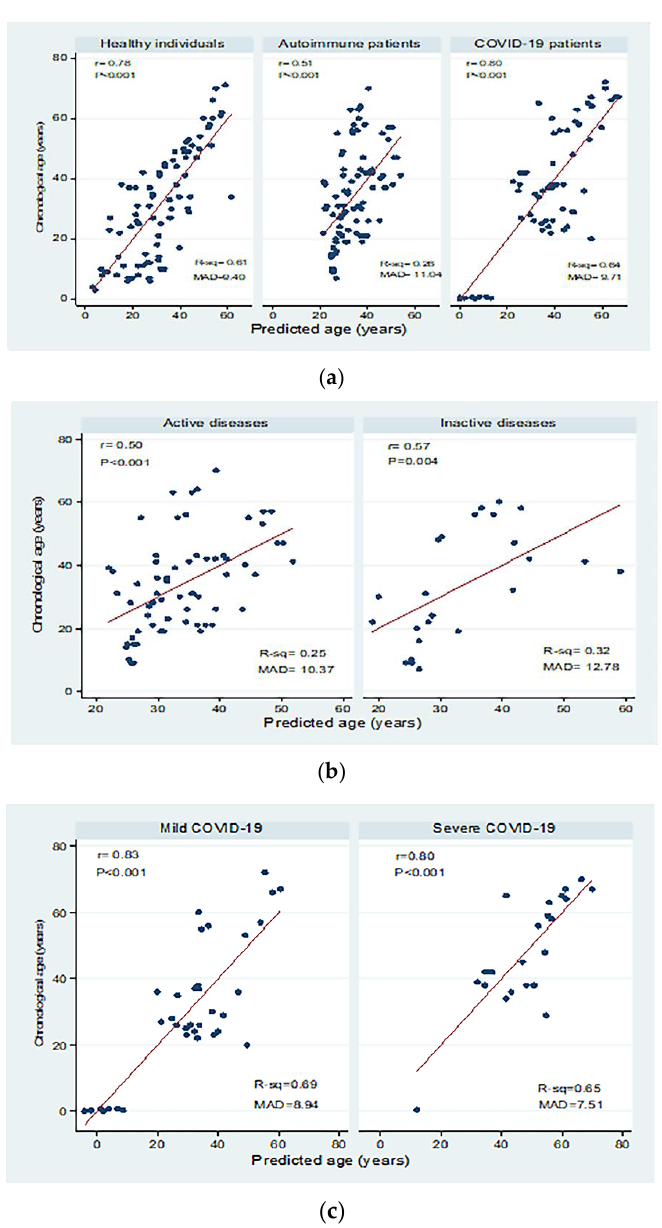
Table 3. Chronological age prediction conditio ned on dCt (CtTBP−CtsjTREC) values in the different study groups. Correlations between chronological age (in years) and predicted age (in years) in the different study groups are shown in Figure 4. There were significant moderate to high positive correlations between chronological age and predicted age for healthy individuals, autoimmune patients, and COVID-19 patients with mean absolute deviations (MAD) of 9.40, 11.04, and 9.71, respectively. Moderate correlations were detected in patients with active and inactive autoimmune diseases, with MAD = 10.37 and 12.78, respectively. There were significant positive correlations between chronological and predicted ages in COVID-19 patients with mild disease (correlation coefficient = 0.84; p < 0.001; MAD = 8.79) R 2 : R-square; Adj. R 2 : adjusted R-square; SE: standard error; MAD: mean absolute deviation; B: re- and severe disease (correlation coefficient = 0.80; p < 0.001; MAD = 7.51). gression coefficient; CI confidence interval; Y: predicted age; X: sjTRECs .